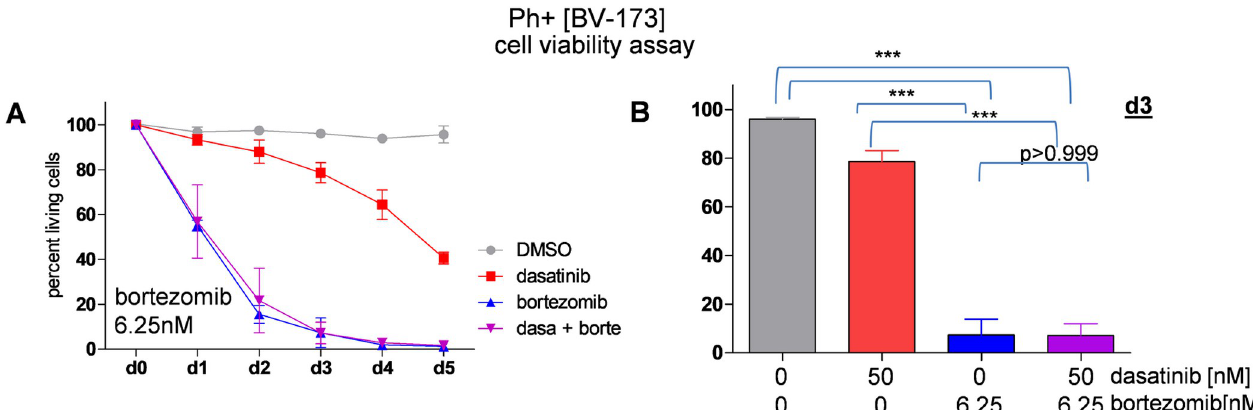
Fig 1. Combination treatment reduces cell viability and induces apoptosis in BV-173 cells. (A) Ph+ cells BV-173 were seeded with DMSO, dasatinib 50nM, bortezomib 6.25nM and the combination at day 0, drugs were replenished every third day, respectively. Viability was measured every 24h until day 5 using PI staining. (B) At day 3 cell viability was significantly reduced to only 7.27% ± 6.6% with bortezomib treatment and 7.16 ± 4.8% with the combination treatment whereas the dasatinib only treated cells were 78.62 ± 4.5% viable. For all analyses, p values were calculated by one-way ANOVA with Bonferroni multiple comparison test. A p value of less than 0.05 was considered statistically significant for all analyses. ( � ,p < 0.05, �� ,p < 0.01, ��� ,p < 0.001), error bars = SD, n = 3/3).